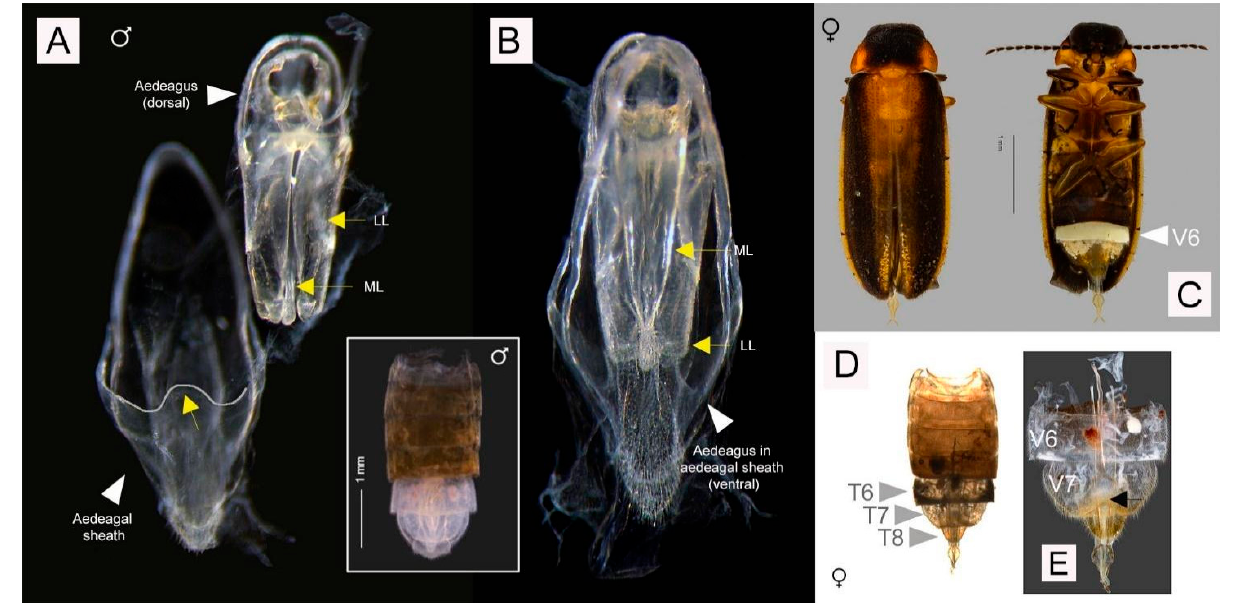
Figure 5. Aedeagal and aedeagal sheath of male ( A , B ) and diagnostic characters of female ( C – E ) of L. singapura sp. nov.; ( A ). Aedeagal sheath, dorsal view, median anterior margin of sheath tergite prolonged and apically truncated, outlined and arrowed; ( B ). Aedeagus, dorsal view and ventral view with arrow indicated median lobe (ML) and lateral lobes (LL); Inset: dorsal view of male abdominal tergites showing aedeagus with aedeagal sheath and tergite 8 still intact; ( C ). Habitus, dorsal and ventral view, LO on V6; ( D ). Dorsal view (after tissue clearing, before dissection), tergites 6-8 indicated; ( E ). Ventral view, dissected part, arrow showing posterior margin of V7 widely emarginated.